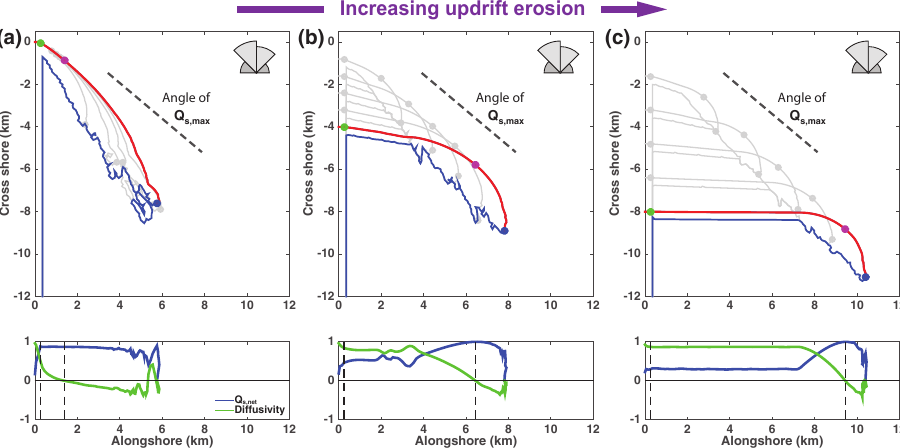
Figure 12. Plan views of modeled spits extending off of a headland eroding at a fixed rate after 137 model years. The only difference between simulations is the rate of imposed headland erosion: (a) F = 0, (b) F = 0 . 08mday − 1 , and (c) F = 0 . 016mday − 1 ( A = 0 . 6 , U = 0 . 2). Plot features explained further in Fig. 4